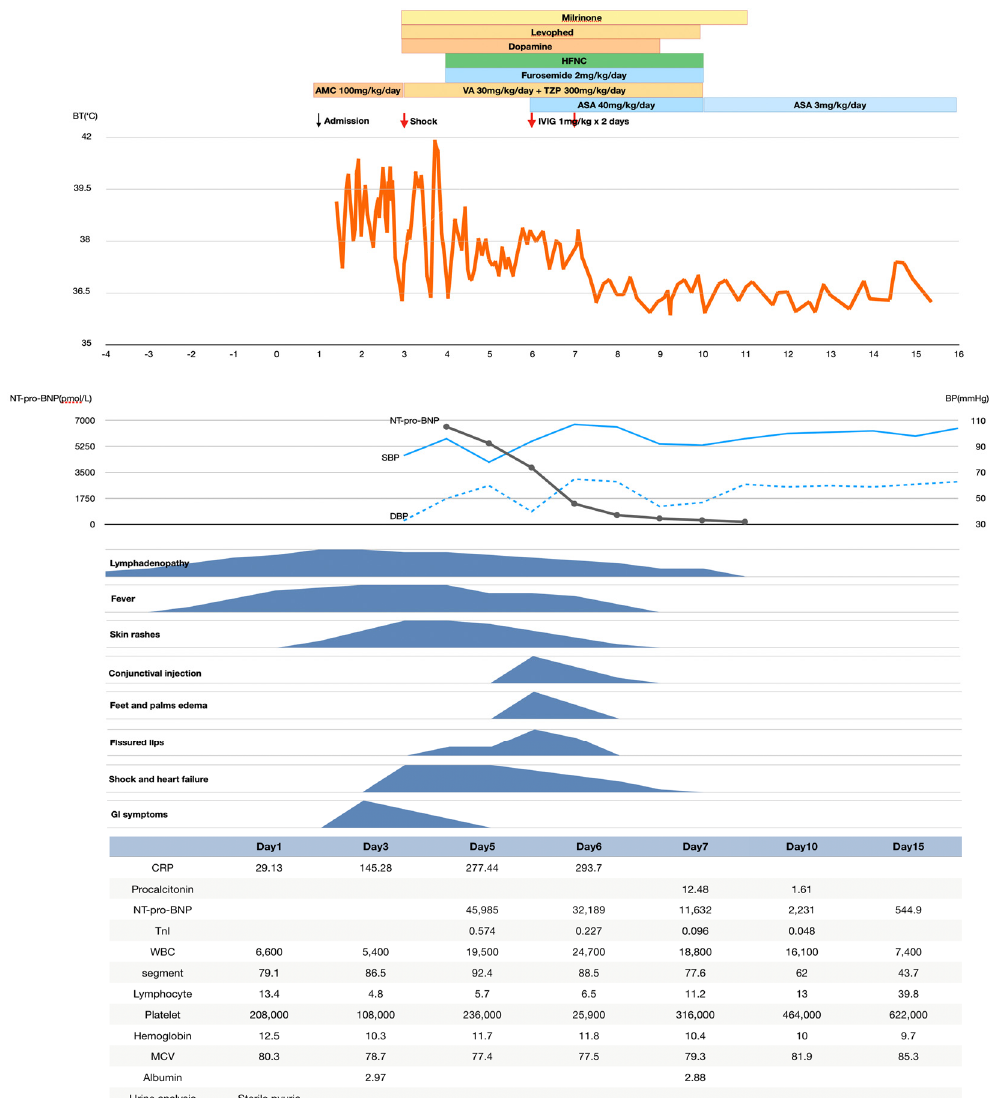
Figure 1. An overview of the patient’s clinical presentation, body temperature, blood pressure, laboratory data, and treatment. The patient had lymphadenopathy one day before fever developed, which is unusual for Kawasaki disease. The patient was treated as a case of acute exudative tonsillitis and cervical lymphadenitis. However, shock developed on the third hospital day even under intravenous antibiotics treatment. Thrombocytopenia was noticed on the third hospital day along with the shock. On the sixth hospital day, the patient fulfilled the diagnosis criteria of Kawasaki disease. Intravenous immunoglobulin and aspirin were administered, which promptly relieved the patient’s fever, hypotension, and KD symptoms. Fortunately, no coronary artery anomaly was revealed on day 48, and low-dose aspirin was discontinued 2 months later. (AMC: amoxicillin/clavulanate potassium; ASA: aspirin; BP: blood pressure; BT: blood temperature; CRP: C-reactive protein; DBP: diastolic blood pressure; HFNC: high-flow nasal cannula; IVIG: intravenous immunoglobulin; MCV: mean corpuscular volume; NT-proBNP: N-terminal pro-brain natriuretic peptide level; SBP: systolic blood pressure; TnI: troponin-